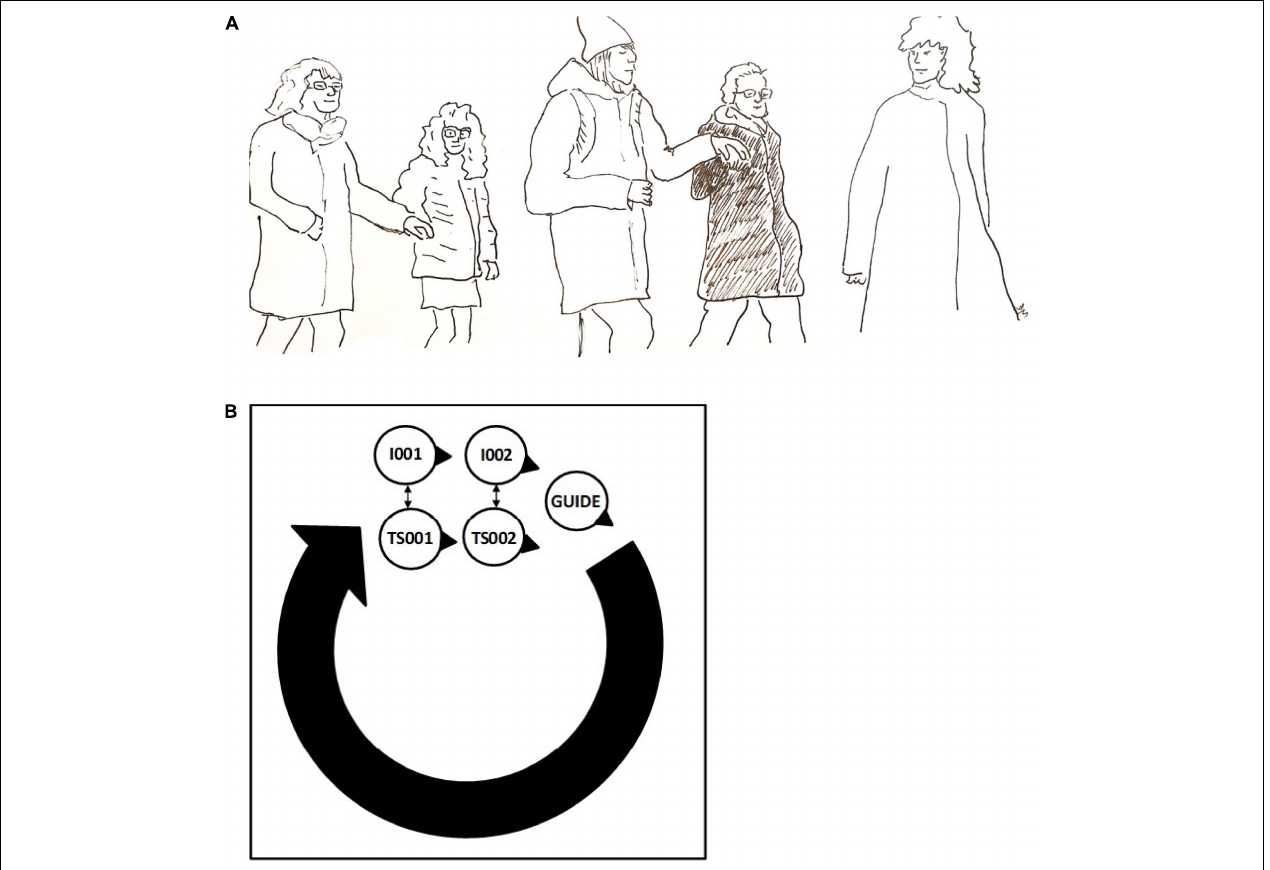
FIGURE 7 | (A) Picture depicting the position of the guide, deafblind individuals and interpreters while walking in a circle. (B) Graph depicting the movement of the participants for the deafblind women to perceive the size of the rose